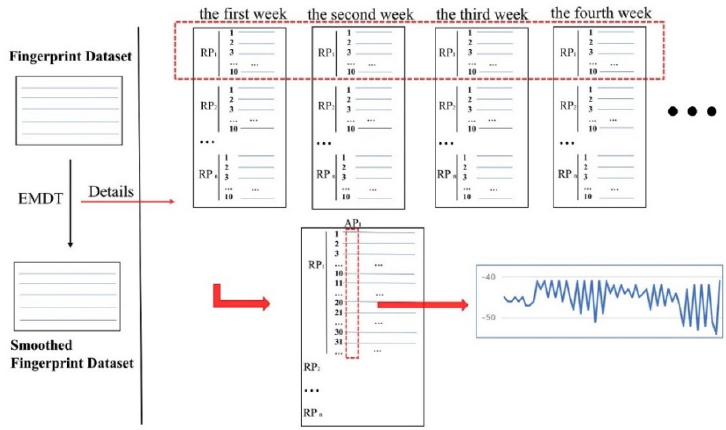
Figure 3. The flow chart of integrating the training RSSI. In Figure 3, the upper red rectangle indicates the integration of all weeks of fingerprints measured at RP 1 ; the lower red rectangle indicates that according to the integrated RP 1 fingerprint data, the RSSIs from AP 1 are selected to construct nonlinear and non-stationary RSSI sequence. The curve graph visualizes the RSSI sequence, with the horizontal axis being the number of measuring times and the vertical axis being the RSSI